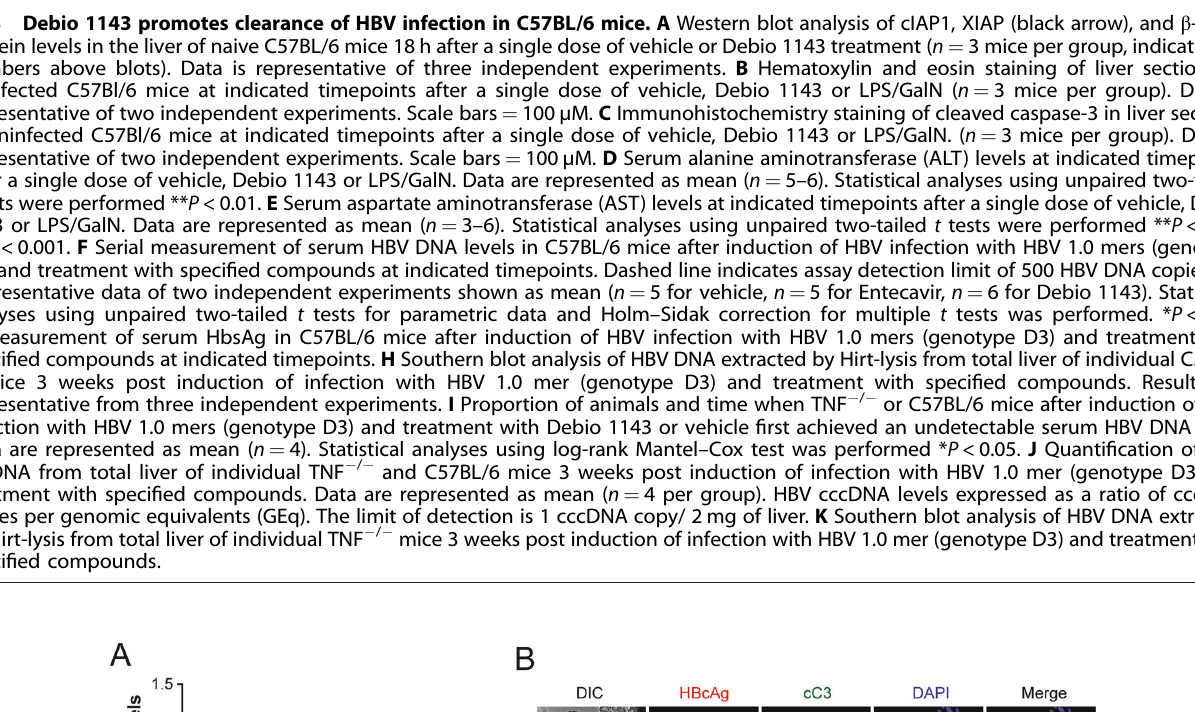
Fig. 3 Debio 1143 promotes clearance of HBV infection in C57BL/6 mice. A Western blot analysis of cIAP1, XIAP (black arrow), and β -Actin protein levels in the liver of naive C57BL/6 mice 18 h after a single dose of vehicle or Debio 1143 treatment ( n = 3 mice per group, indicated by numbers above blots). Data is representative of three independent experiments. B Hematoxylin and eosin staining of liver sections of uninfected C57Bl/6 mice at indicated timepoints after a single dose of vehicle, Debio 1143 or LPS/GalN ( n = 3 mice per group). Data